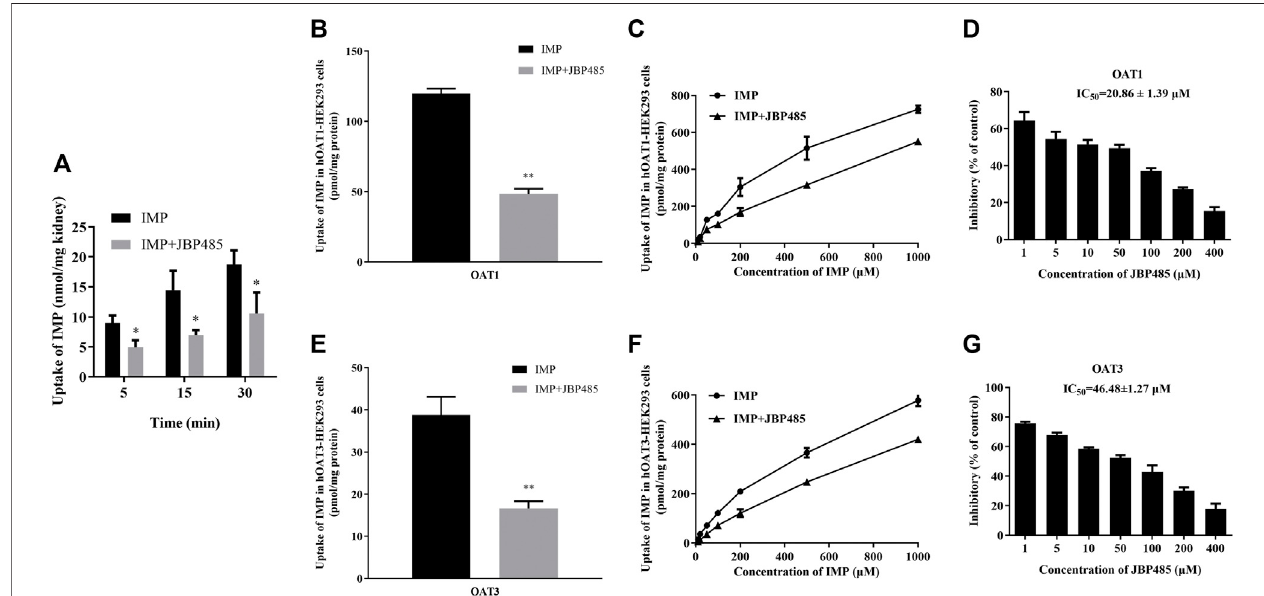
FIGURE 4 | Effect of JBP485 on the uptake of IMP by rat kidney slices and hOAT1/3-HEK293 cells. Inhibition effect of JBP485 (50 μ M) on the uptake of IMP (50 μ M) in kidney slices (A) . Inhibition effect of JBP485 (50 μ M) on the uptake of IMP (50 μ M) in hOAT1/3-HEK293 cells (B,E) . Inhibition effect of JBP485 (50 μ M) on the uptake of IMP (10 – 1,000 μ M) in hOAT1/3-HEK293 cells (C,F) . Inhibition effect of JBP485 (1 – 400 μ M) on the uptake of IMP (50 μ M) in hOAT1/3-HEK293 cells (D,G) . Data are expressed as the mean ± SD. * p < 0.05 and ** p < 0.01 compared with control ( n = 3).